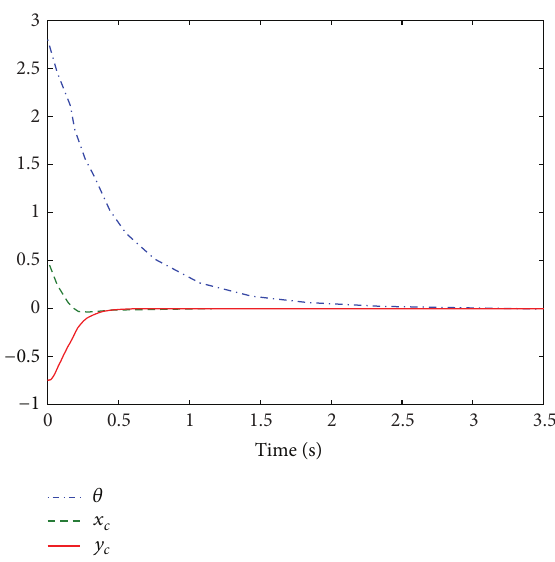
Figure 1: The responses of states 𝜃 , 𝑥 𝑐 , and 𝑦 𝑐 with respect to